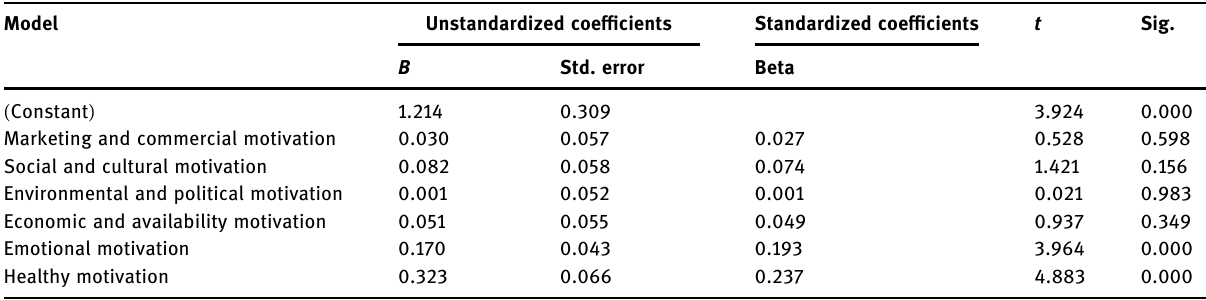
Table 13: Coe ffi cients for model one ( dependent variable: healthy diet behavior and attitude )